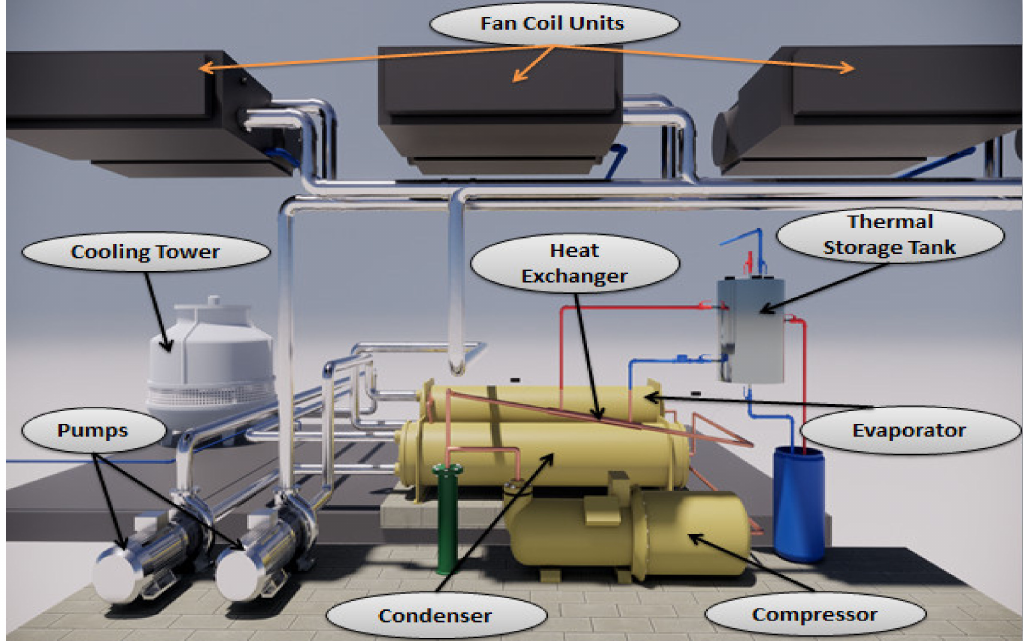
Figure 6. Schematic of the water chiller air-conditioning system combined with thermal storage.